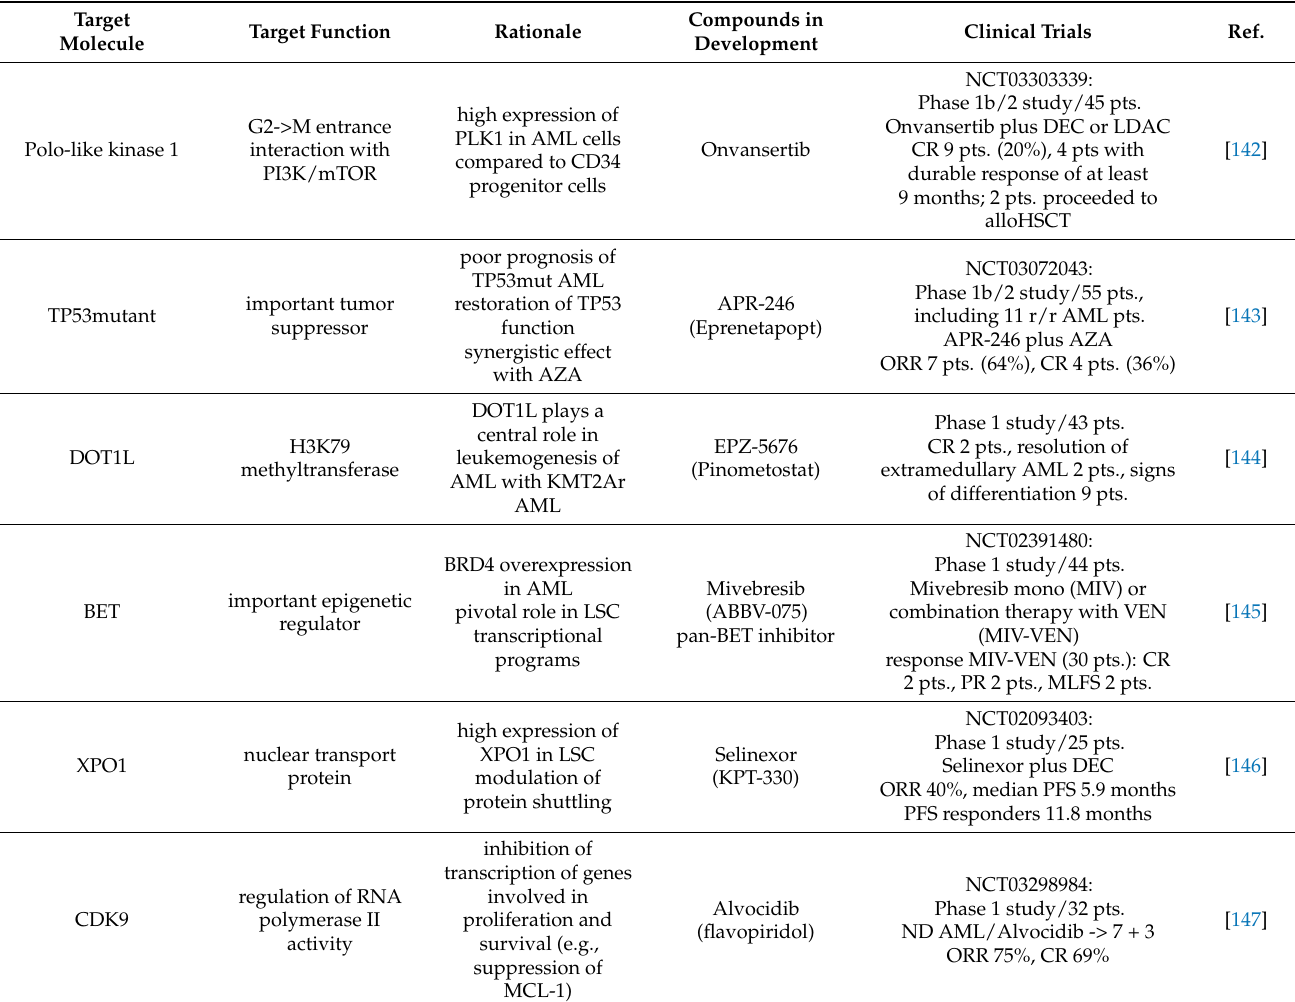
Table 1. Targeted therapy approaches in r/r AML and corresponding clinical